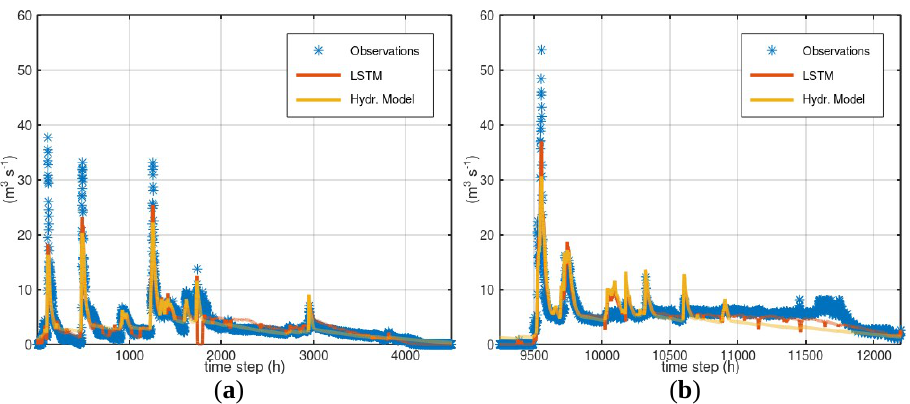
Figure 11. Simulation of Bakas River training period for ( a ) time steps 1–4500 and ( b ) time steps 9250–12,200 (note the observed steady flow between time steps 10,000 and